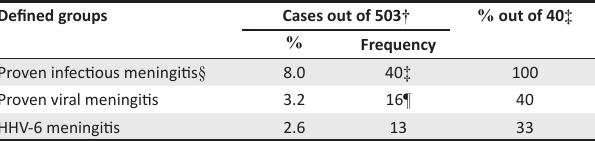
TABLE 2: Classification of cases based on clinical and molecular findings, Khartoum, Sudan, December 2009 – August 2010. Defined